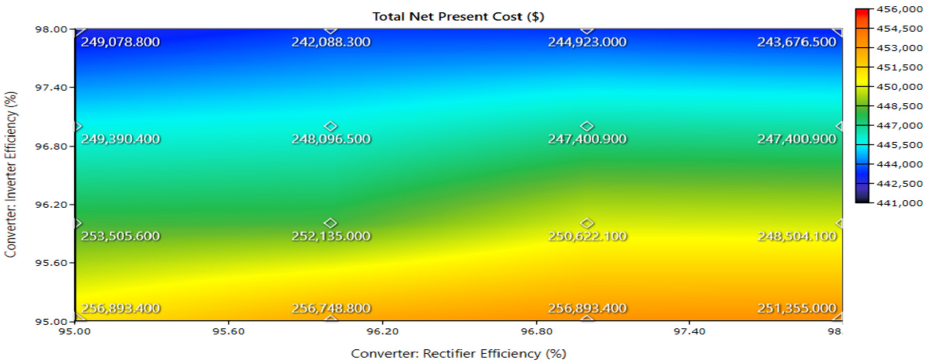
Figure 22. Variation of net present cost considering fluctuation of inverter and rectifier efficiency (superimposed: PVS power production).